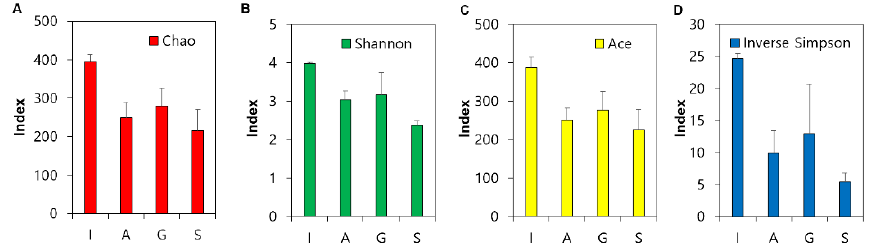
Figure 3. Alpha-diversity indices of the communities: Chao ( A ), Shannon ( B ), Ace ( C ), and Inverse Simpson ( D ).